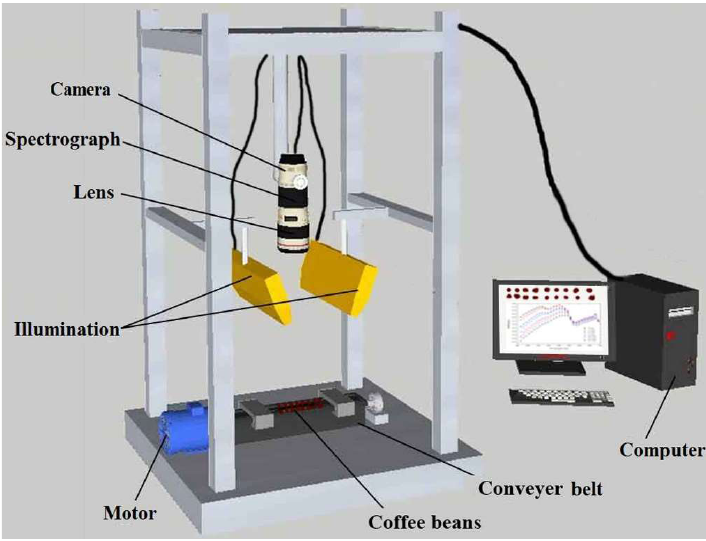
Figure 1. Schematic diagram of the main components of the hyperspectral imaging system.